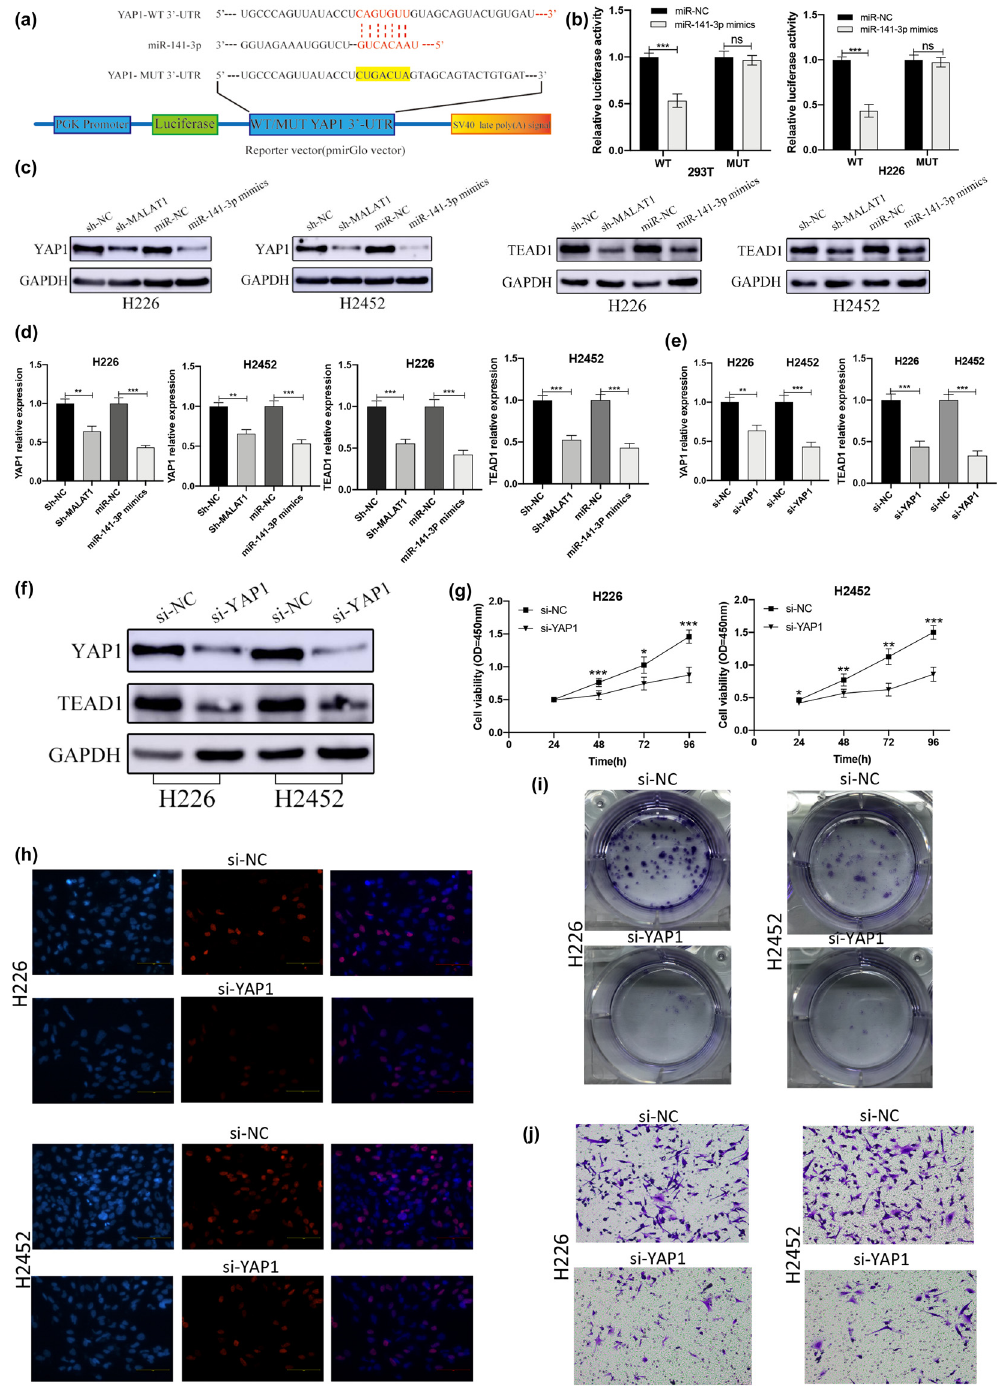
Figure 5: YAP1 is the direct target of miR - 141 - 3p, and knockdown of YAP1 inhibits the proliferation of MPM cells. ( a ) Prediction of the binding site between miR141 - 3p and YAP1. ( b ) The e ff ect of miR - 141 - 3p mimics on the luciferase activity of genes with WT or MUT YAP1 target regions ( *** P < 0.001, t - test ) . ( c ) The e ff ects of sh - MALAT1 and miR - 141 - 3p mimics on the expression levels of YAP1 and TEAD1 proteins were detected by Westernblotting. ( d ) Thein fl uencesofsh - MALAT1andmiR - 141 - 3pmimicsonthemRNAexpressionlevelsofYAP1andTEAD1weredetectedbytheRT - qPCR ( ** P < 0.01, *** P < 0.001, t - test ) . ( e ) The RT - qPCR showed that the mRNA expression levels of YAP1 and TEAD1 in si - YAP1 - transfected cells were lower than thoseinsi - NCgroup ( ** P < 0.01, *** P < 0.001, t - test ) . ( f ) Westernblottingshowedthat theexpression levels ofYAP1 andTEAD1 insi - YAP1 transfected cells were lower than those in the si - NC group. ( g ) The e ff ect of si - YAP1 on the cell viability was determined by CCK - 8 ( * P < 0.05, ** P < 0.01, *** P < 0.001, t - test ) . ( h ) The e ff ect of si - YAP1 on the cell proliferation was detected by EdU assay. ( i ) The e ff ect of YAP1 on the cell proliferation was evaluated using the colony formation assay. ( j ) The e ff ect of YAP1 on the cell invasion was detected by Transwell invasion